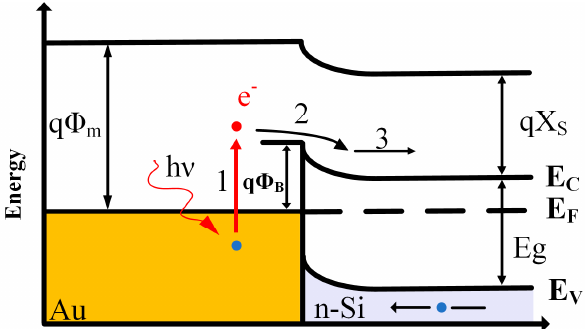
Figure 3. Schematic of the hot electron transfer process over the Schottky barrier formed by the metal-semiconductor interface. Steps 1 to 3 correspond to hot electron generation, diffusion to the Schottky interface, and transmission to the conduction band of the semiconductor.